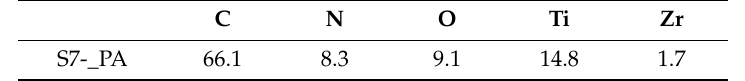
Table 2. The elemental analysis of the proposed composite material after selective laser sintering (SLS).